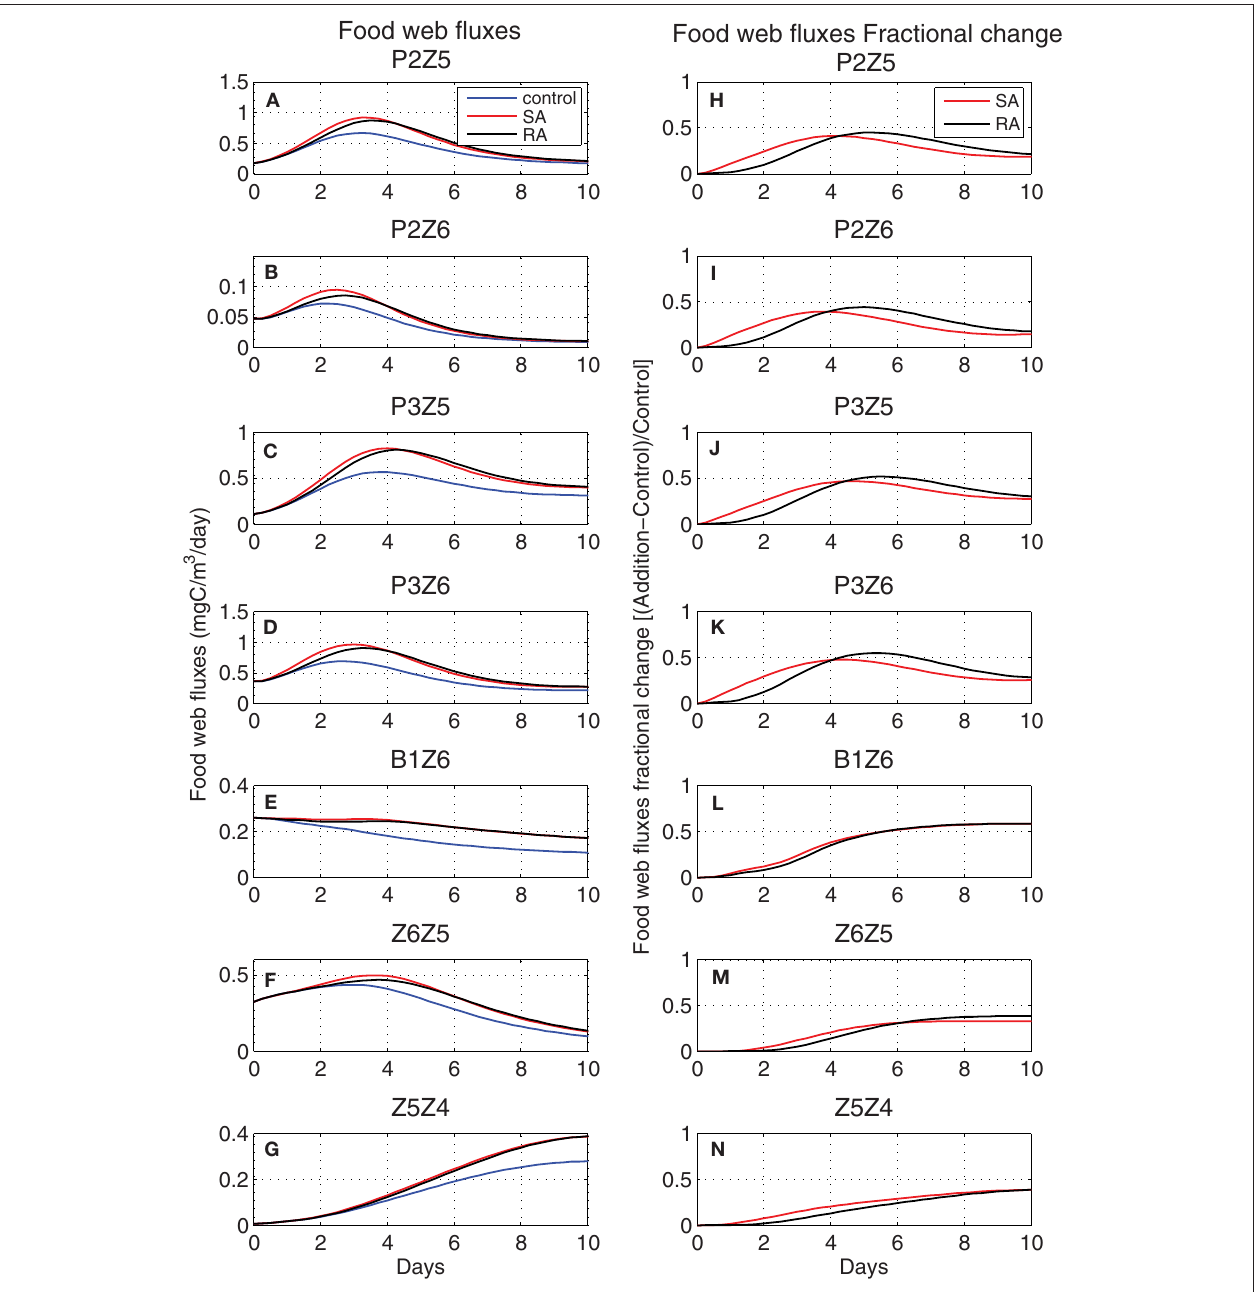
FIGURE 5 | Evolution of food web carbon fluxes (left, mgC/m 3 /day) for (A) P2Z5, (B) P2Z6, (C) P3Z5, (D) P3Z6, (E) B1Z6, (F) Z6Z5, (G) Z5Z4 in Control (blue line) and Addition (SA red line, RA black line) treatments and respectively their fractional change [(Addition P3, picophytoplankton; B1, bacteria; Z6, HNAN; Z5, microzooplankton; Z4, mesozooplankton (see Figure 1